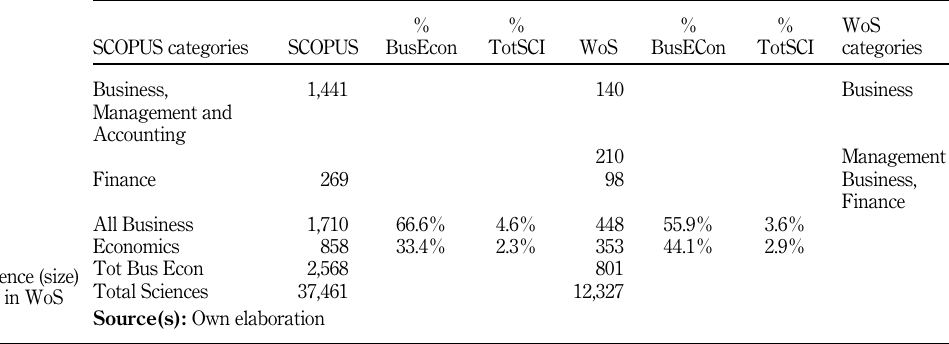
of disciplines in WoS vs